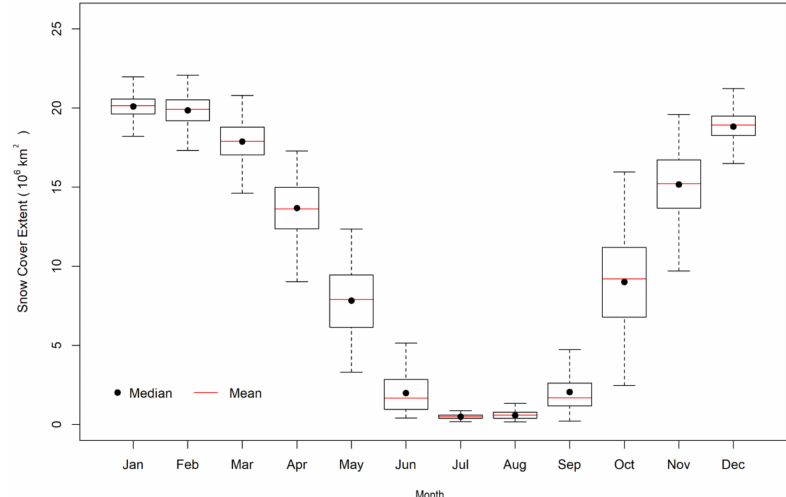
Figure 4. Average monthly variation of SCE in the study area from 2000 to 2016. The black dots and red lines represent median and mean values,